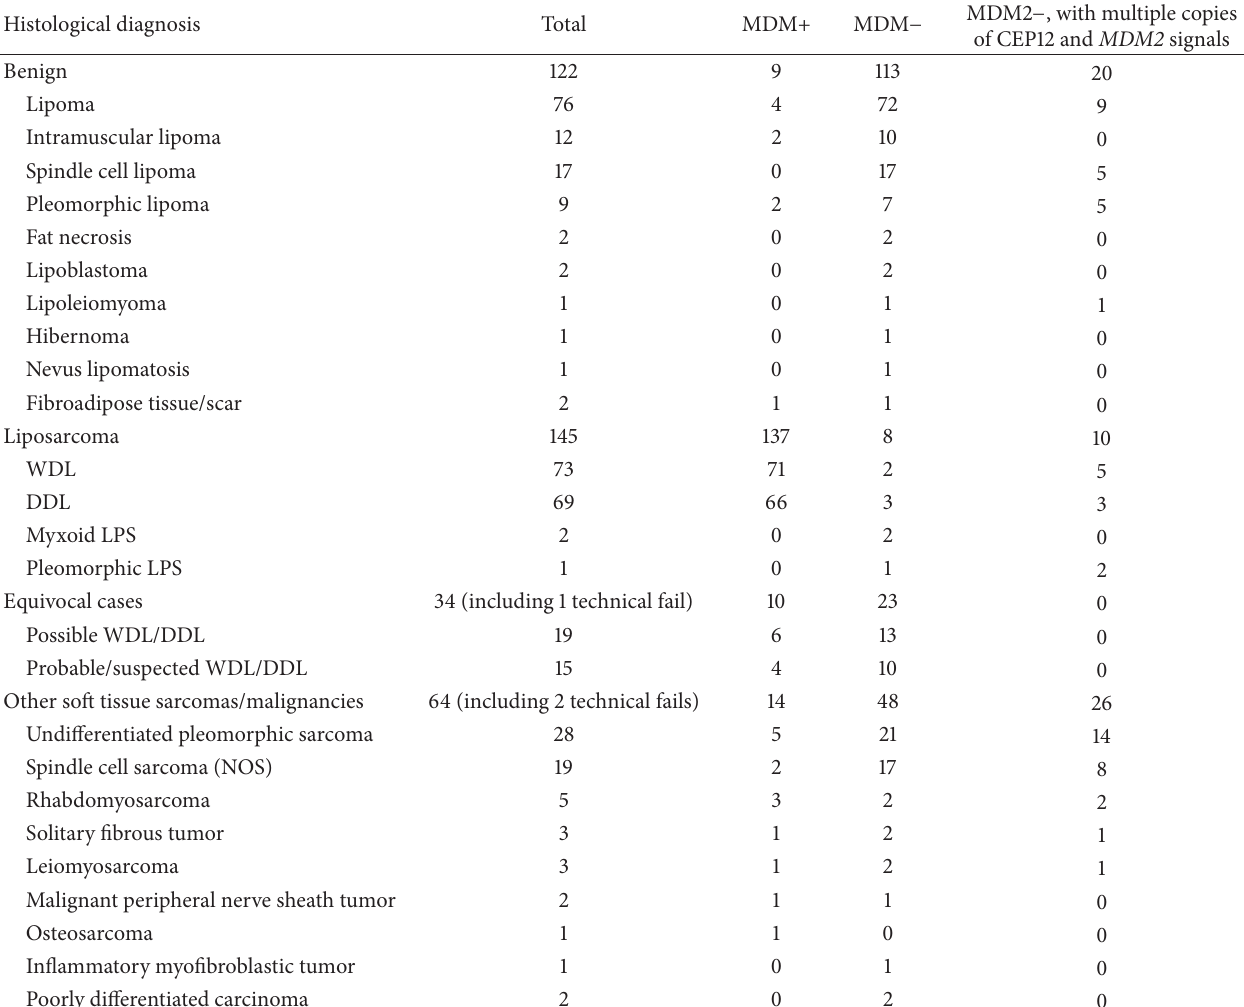
Table 2: Comparison of histological tumor type and FISH